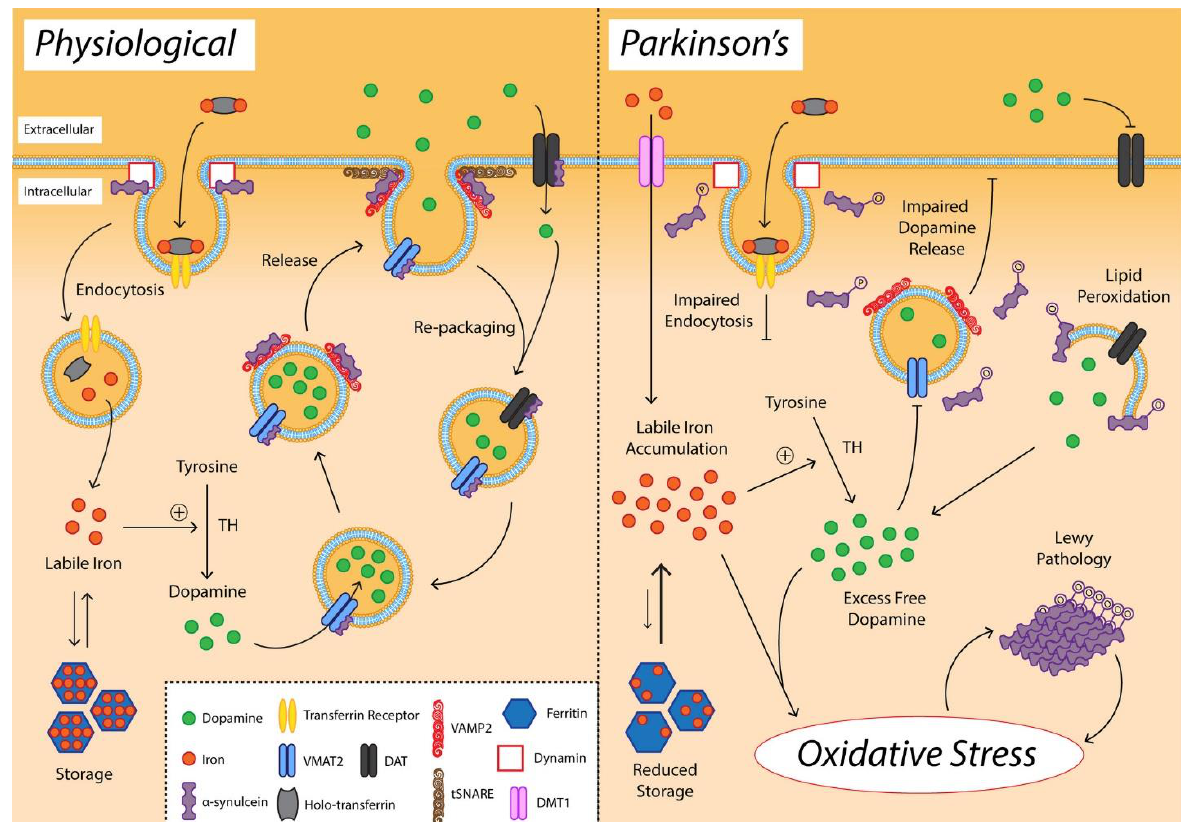
Figure 3. Schematic representation of alterations in dopamine, iron, and alfa-synuclein promoting oxidative stress in the substantia nigra pars compacta. Reprinted from an open-access source Table 1. Summary of active clinical trials investigating Parkinson ’ s disease in relation to oxidative stress. The studies have been retrieved from clinicaltrials.gov with search keywords “ Condition or disease = Parkinson disease ” and “ Other terms = oxidative stress ” and selecting the items with the status “ Recruiting ” and “ Active, not recruiting ” .